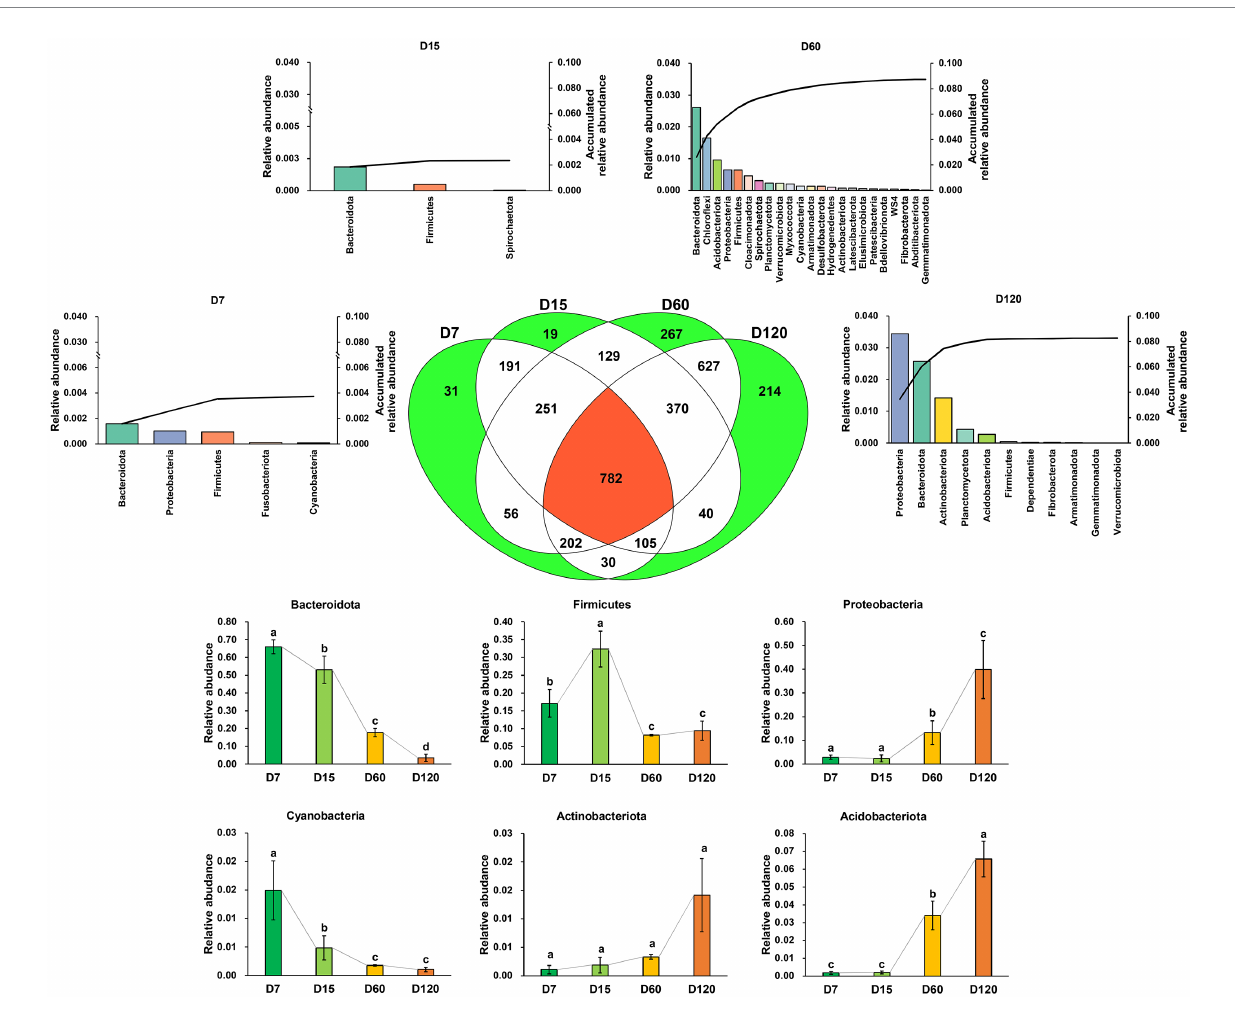
FIGURE 2 A Venn diagram showing the zOTU distribution in different stages. The bar charts denoted with stage name indicate the taxonomic composition and their accumulated relative abundance of the unique zOTUs in the stage. The bar charts at the bottom of the figure showed the variation of the dominant phyla of the shared zOTUs. Different letters indicate significant differences as checked by the Kruskal-Wallis rank sum test ( p < 0.05).